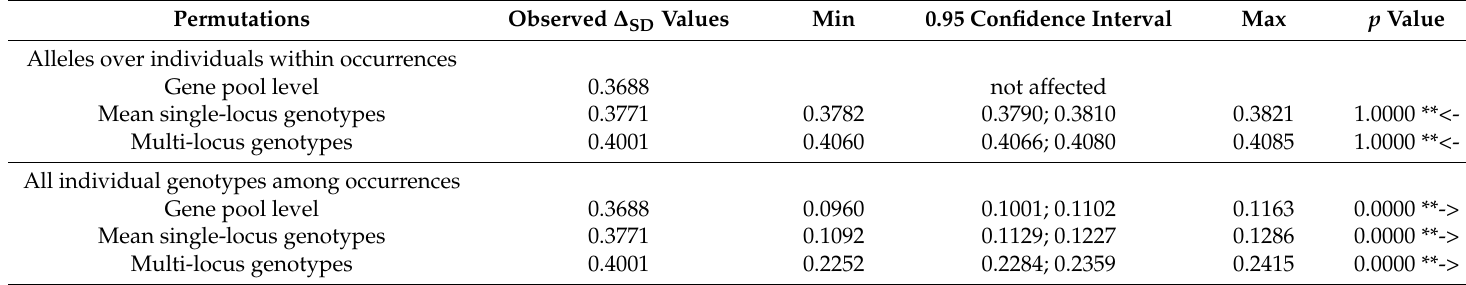
Table 4. Permutation analysis of alleles over individuals within occurrences and of all individual genotypes among occurrences. The values are based on 10,000 permutations for all 16 loci. The observed ∆ SD value is shown for the three integration levels. The calculated minimum and maximum ∆ SD values, the 95% confidence interval as well as the permutation ( p ) values are shown. The symbols **-> (upper part of the distribution) and **<- (lower part of the distribution) indicate that fewer than 1% and more than 99% of the permutations yielded ∆ SD values that are significantly equal or greater than the observed distance. ** = p ≤